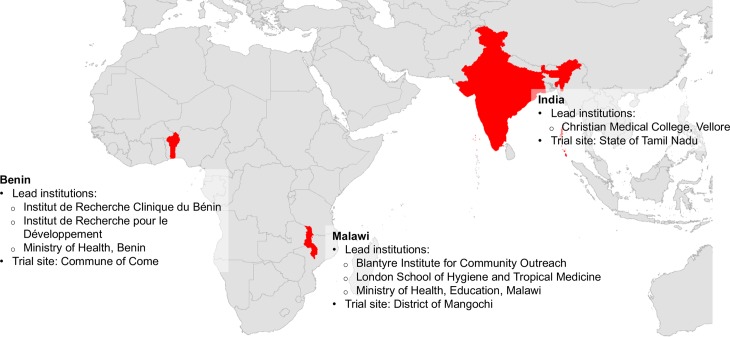
DeWorm3 trial sites and partners.Figure created for DeWorm3 using shapefiles from GADM database of Global Administrative Areas 2012, version 2.0 (gadm.org) and ArcGIS Desktop: Release 10 (Redlands, CA).